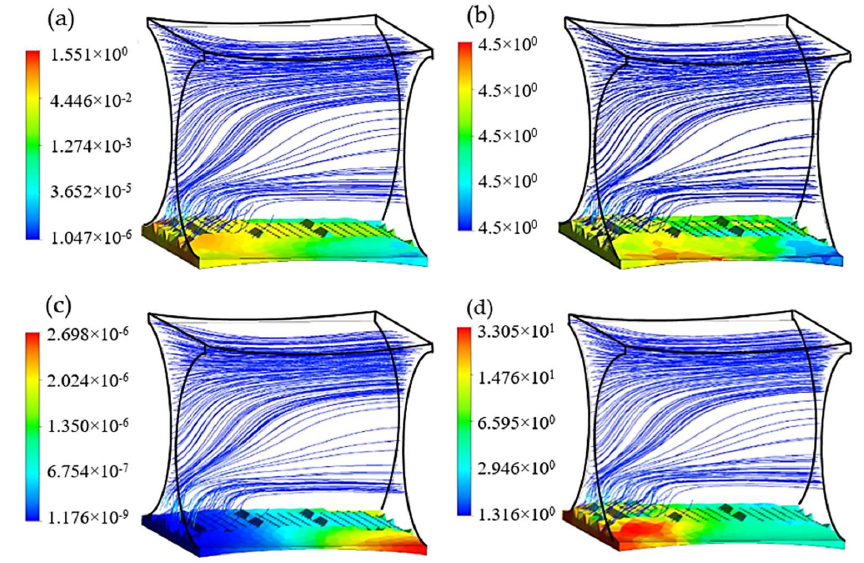
Figure 9. Cartilage cell culture within the improved geometry after 30 days cultivation with initial cell density = 5 × 10 7 cells/cm 3 ( a ) Shear stress (Pa); ( b ) Glucose concentration (kg/m 3 ); ( c ) Lactate concentration (kg/m 3 ) and ( d ) Cell density × 10 7 (cells/cm 3 ) in biomass domain.